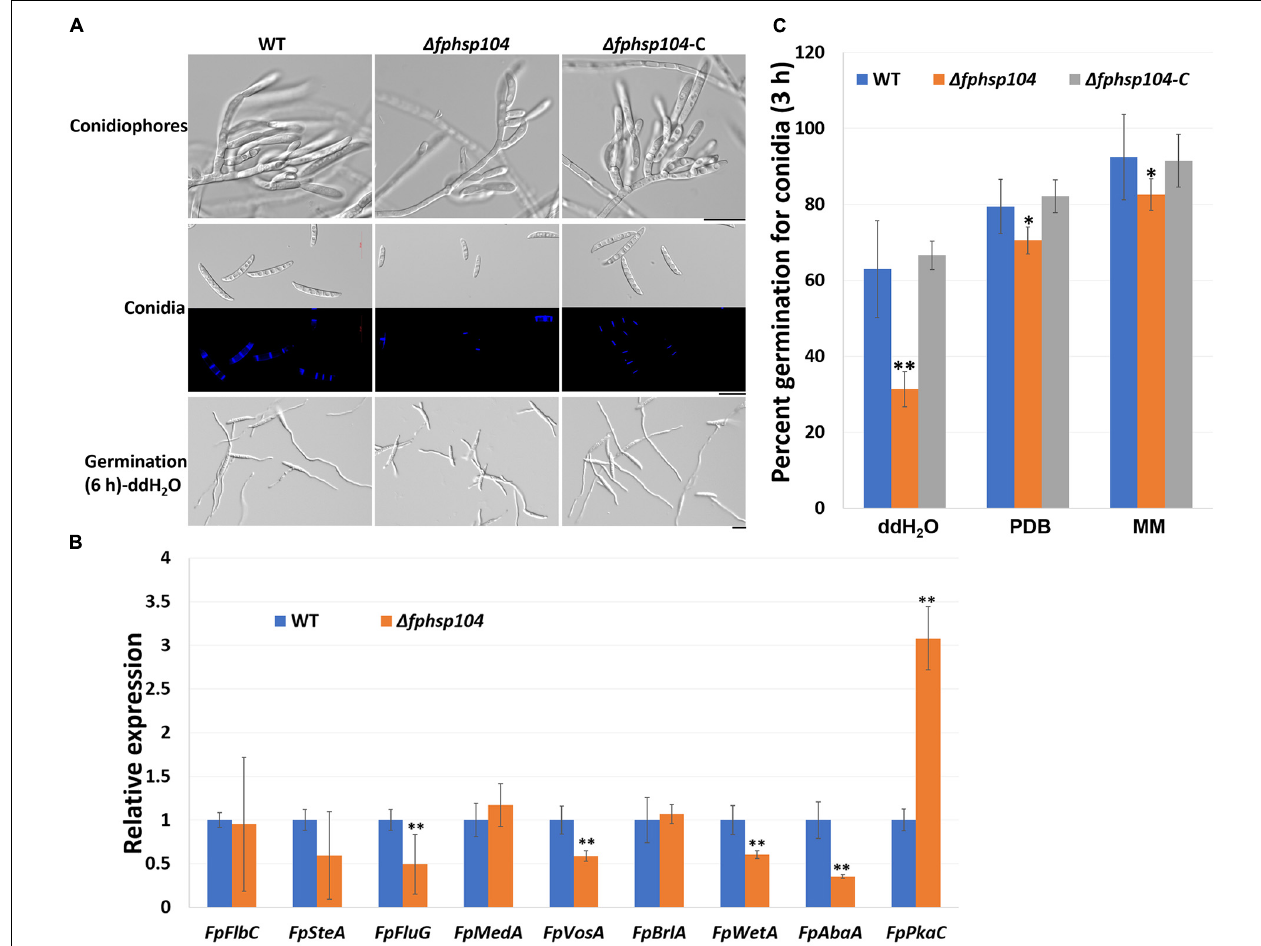
FIGURE 6 | Conidiation and conidia germination assays. (A) Microscopy images of conidiophores and conidia produced in CMC medium for 4 days and conidia formation induced in sterile water for 6 h. Bar = 20 µ m. (B) qRT-PCR analyses of nine conidiation-related genes in wild-type (WT) and (cid:49) fphsp104 strains. Transcript level fold of the selected gene was calculated relative to the level at WT. FpTEF1a gene was used as a reference. Bars represent standard deviation based on four replicates. ∗∗ p < 0.01 ( t -test). FpFlbC , FPSE_02736; FpSteA , FPSE_01067; FpFluG , FPSE_04527; FpMedA , FPSE_01933; FpVosA , FPSE_11893; FpBrlA , FPSE_00757; FpWetA , FPSE_02660; FpAbaA , FPSE_11664; FpPkaC , FPSE_00184. (C) Conidia germination rates of WT, (cid:49) fphsp104 , and (cid:49) fphsp104 -C strains cultured in sterile water, potato dextrose broth (PDB), and minimal medium (MM), respectively. Bars represent SD of three independent experiments. ∗∗ p < 0.01, ∗ p < 0.05 ( t -test).